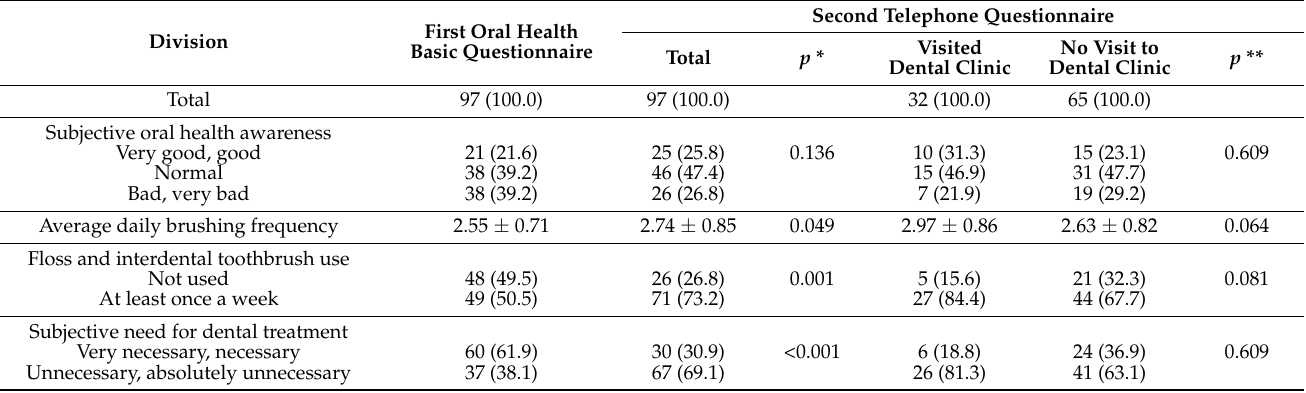
Table 5. Oral health awareness, average daily brushing frequency, floss and interdental toothbrush use, and need for dental